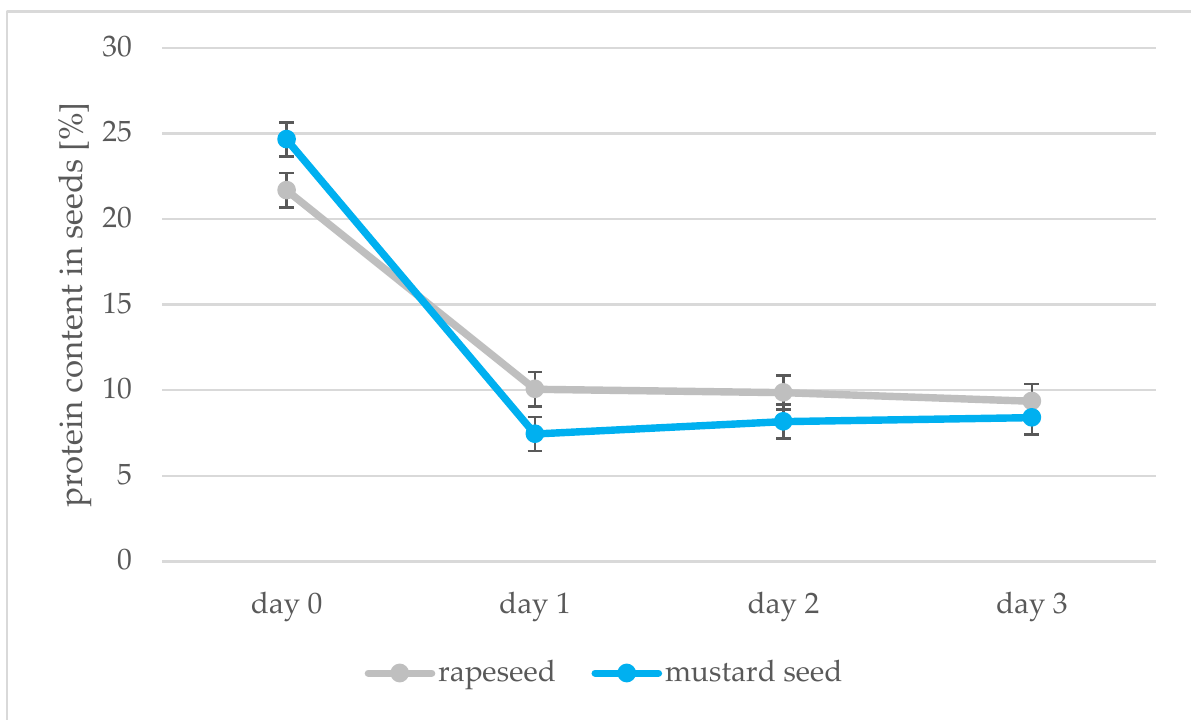
Figure 7. Protein content [%] in rapeseeds and mustard seeds during germination (days 0, 1, 2, 3).